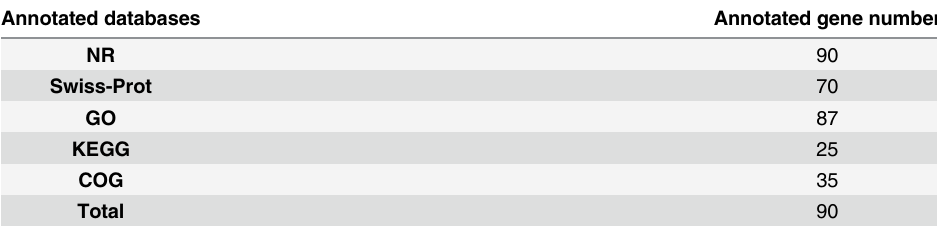
Table 7. Statistics of association regional gene